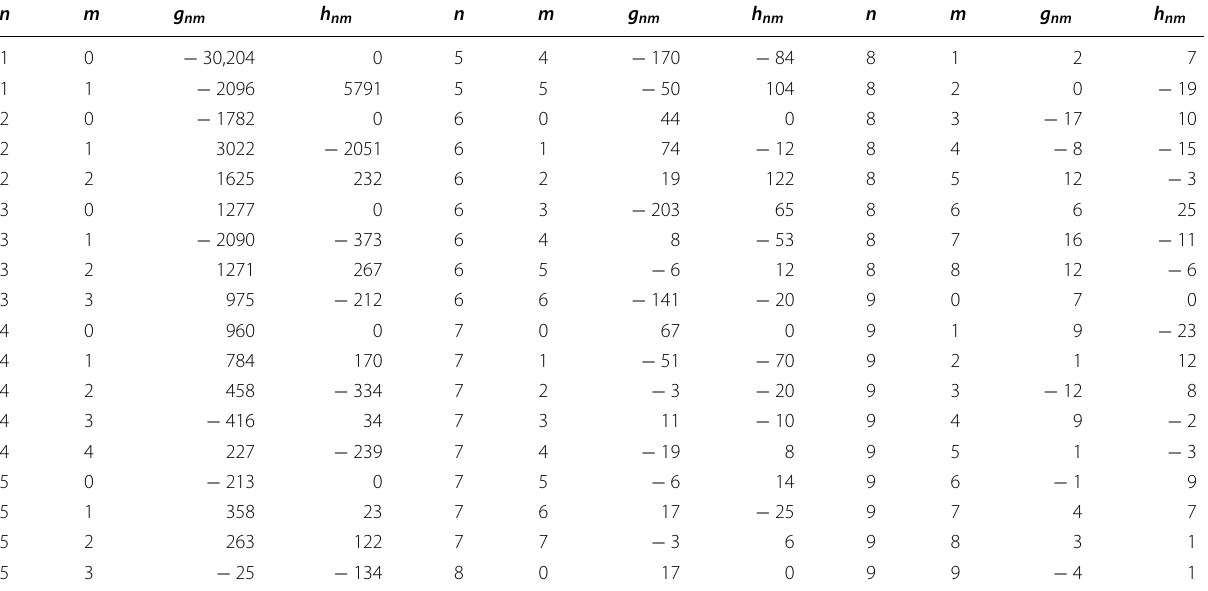
Table 6 Gauss coefficients of the geomagnetic field model at 1970.0 epoch (M-2) based on the measurements from the Kosmos-321 satellite (Dolginov et al. 1976) (the coefficients are listed in three